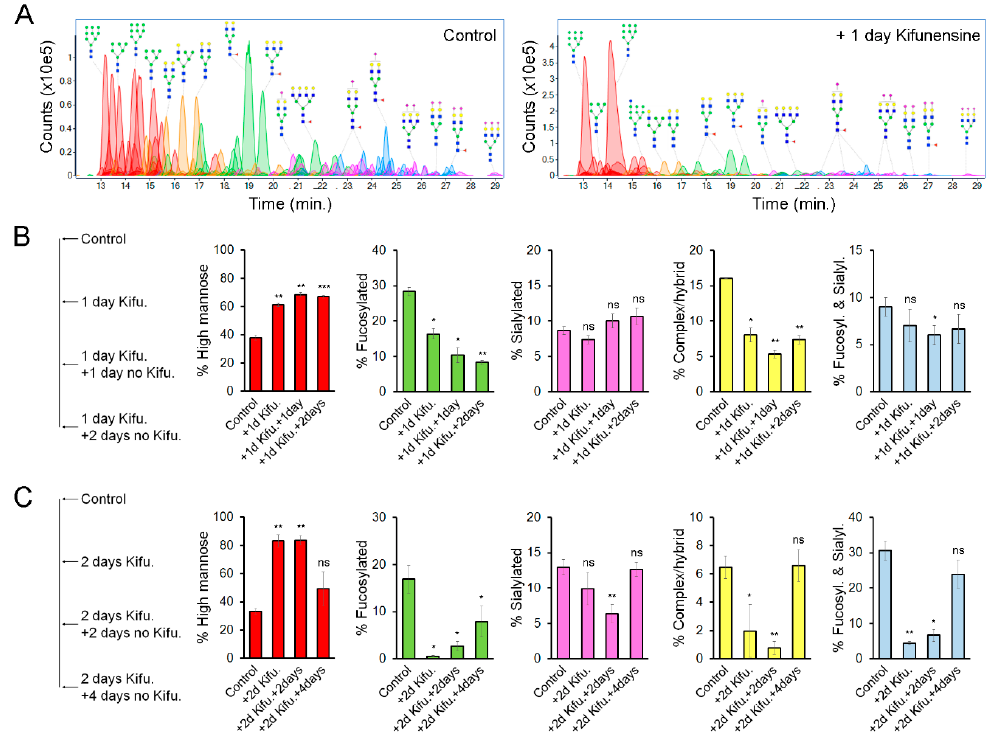
Figure 3. Effect of Kifunensine on N-glycans over time. ( A ) Representative chromatograms of N- glycans detected by MS of MSCs treated for one day with or without Kifunensine. ( B ) without Kifunensine. At these time points, increased high mannose N-glycans persist, while